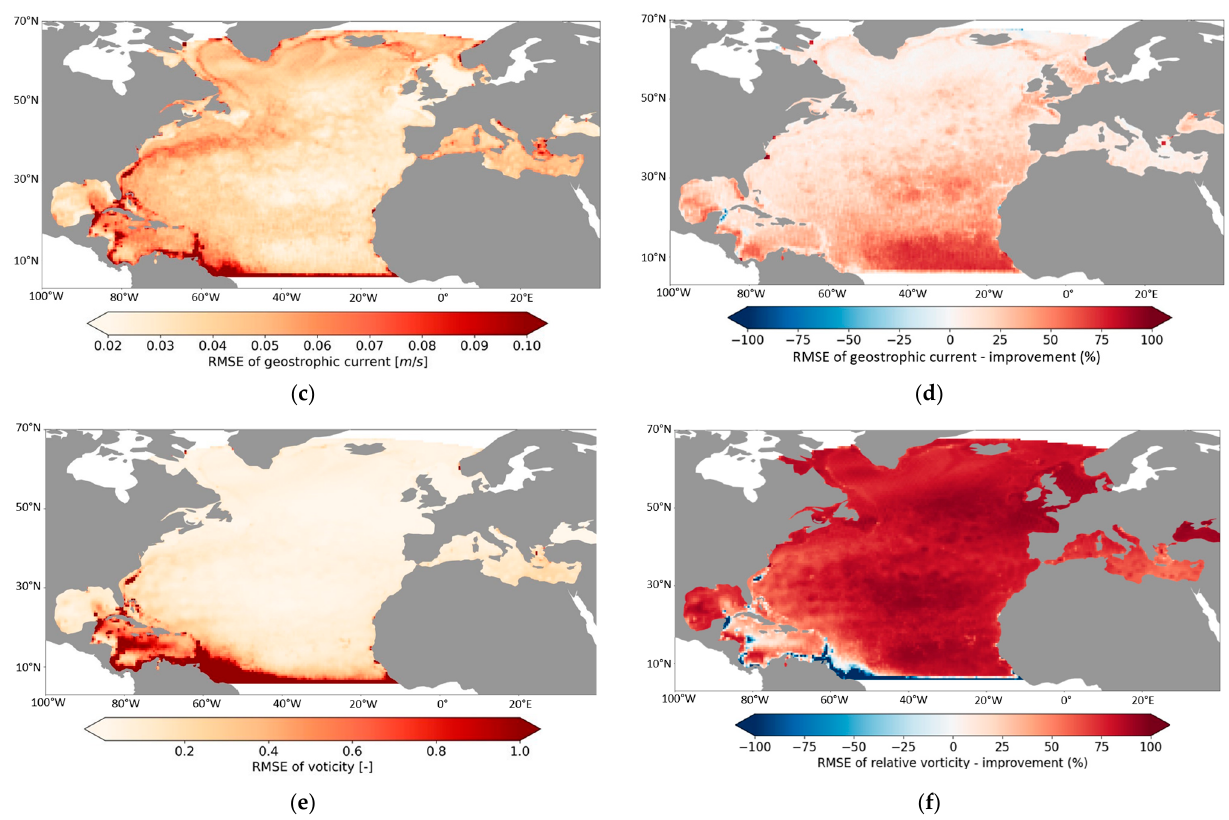
Figure 7. Variance of SSH residuals ( a ), RMSE of geostrophic current ( c ) and relative vorticity ( e ) and their comparison with the Gomez filter (( b ), ( d ) and ( f ), respectively) over the North Atlantic Ocean. Red on the comparison map indicates that the U-Net performs better than the Gomez filter while blue indicates the opposite.